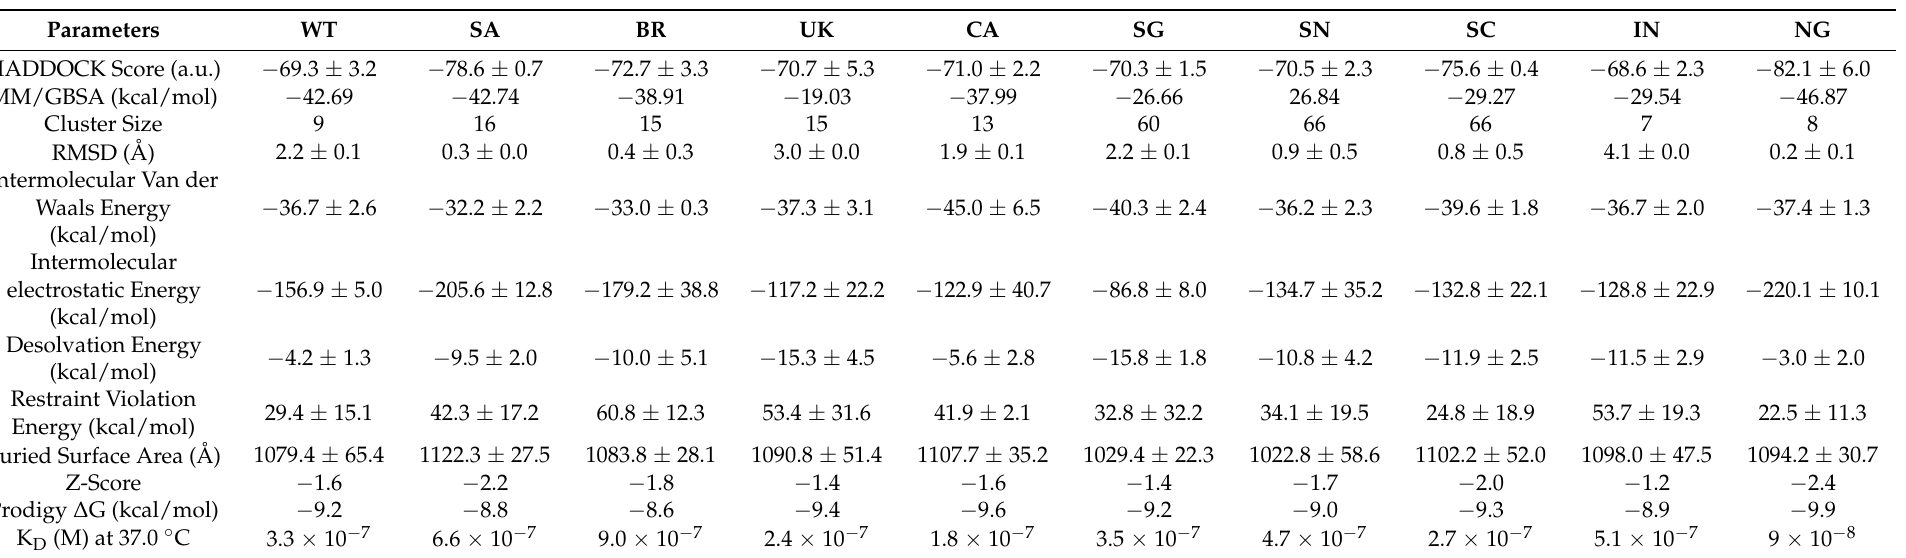
Table 2. The HADDOCK docking predictions for all bromelain-derived peptide with RBD variants complexes, along with additional parameters such as cluster size, Van der Waals energy, electrostatic energy, and Z-score. The KD and MM/GBSA free binding energy (kcal/mol) are also included in the